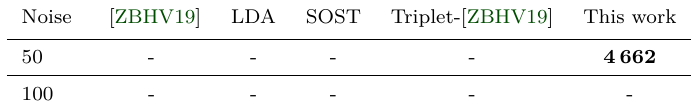
Table 8: Benchmark the attack performance ( T GE 0 ) with the AES_HD dataset perturbed with desynchronization.